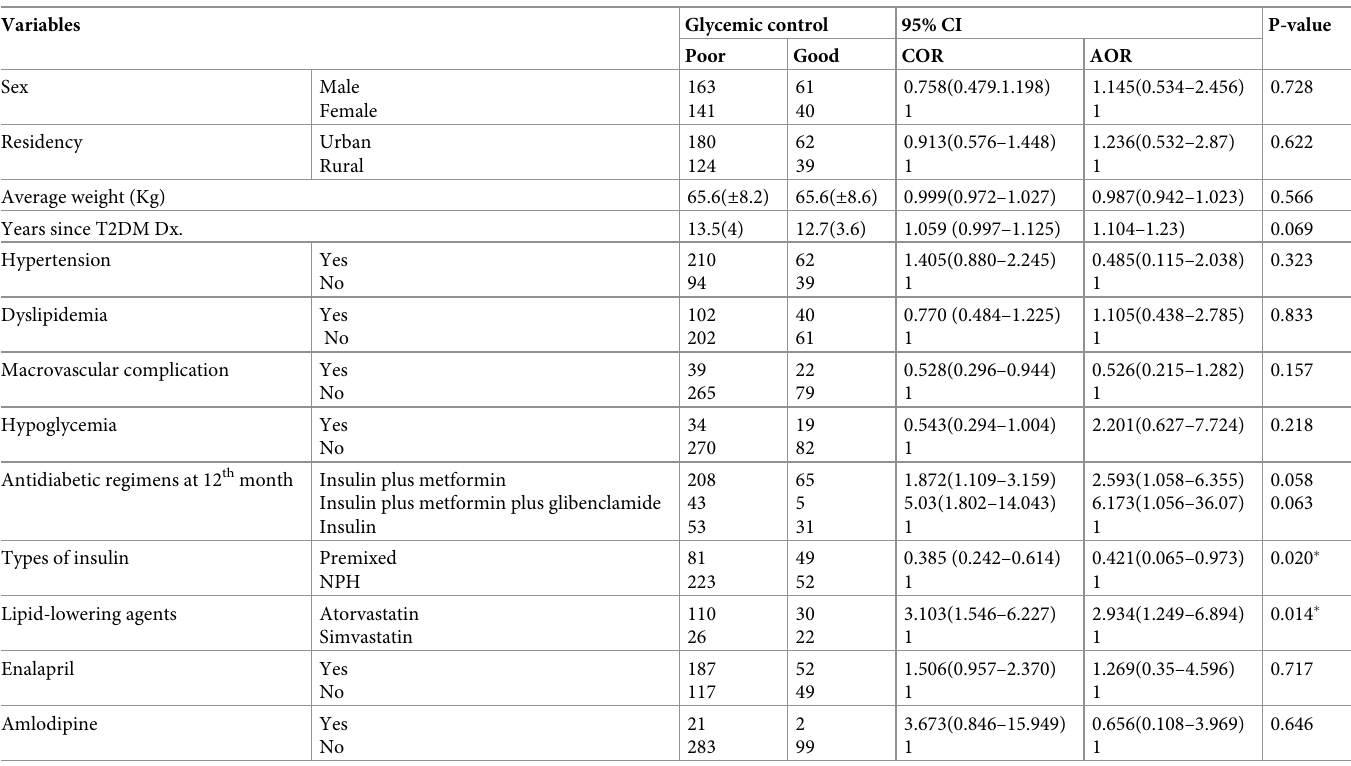
Table 6. Association of NPH and premixed insulin and other predicted variables with glycemic control.